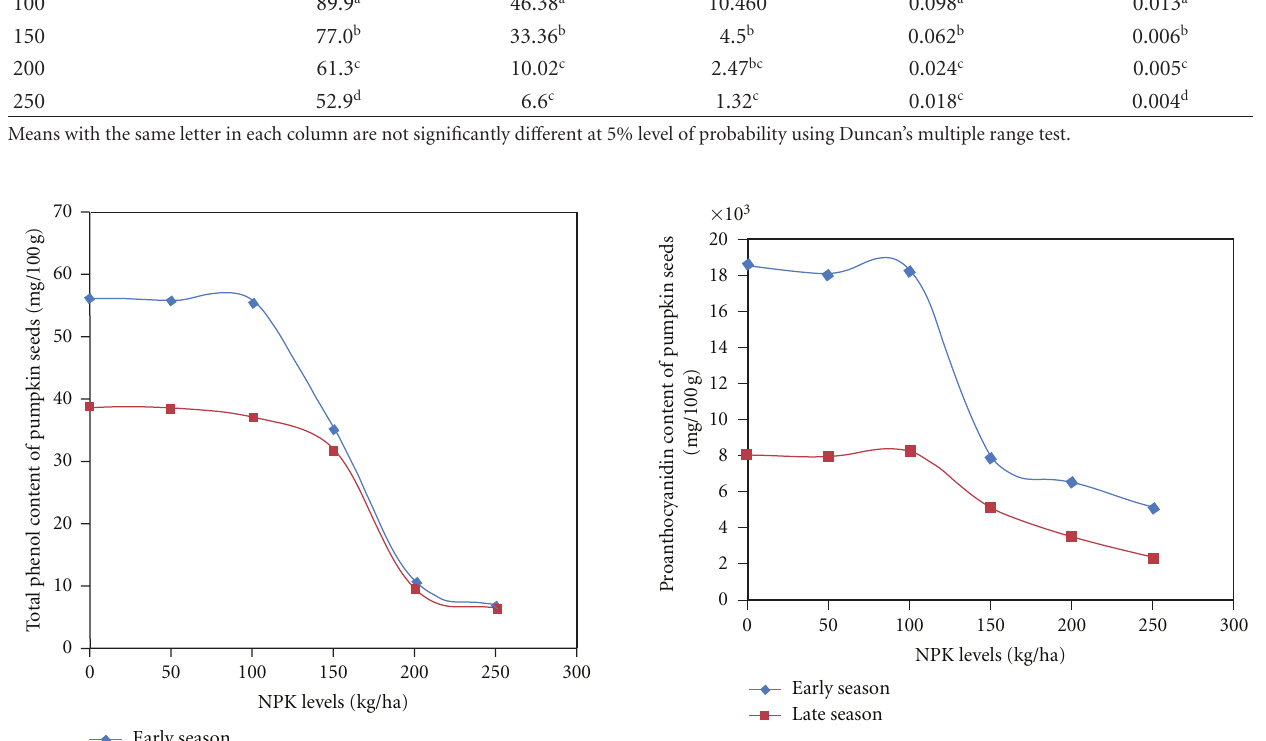
Figure 6: Proanthocyanidin content of pumpkin seeds as a ff ected by season by NPK